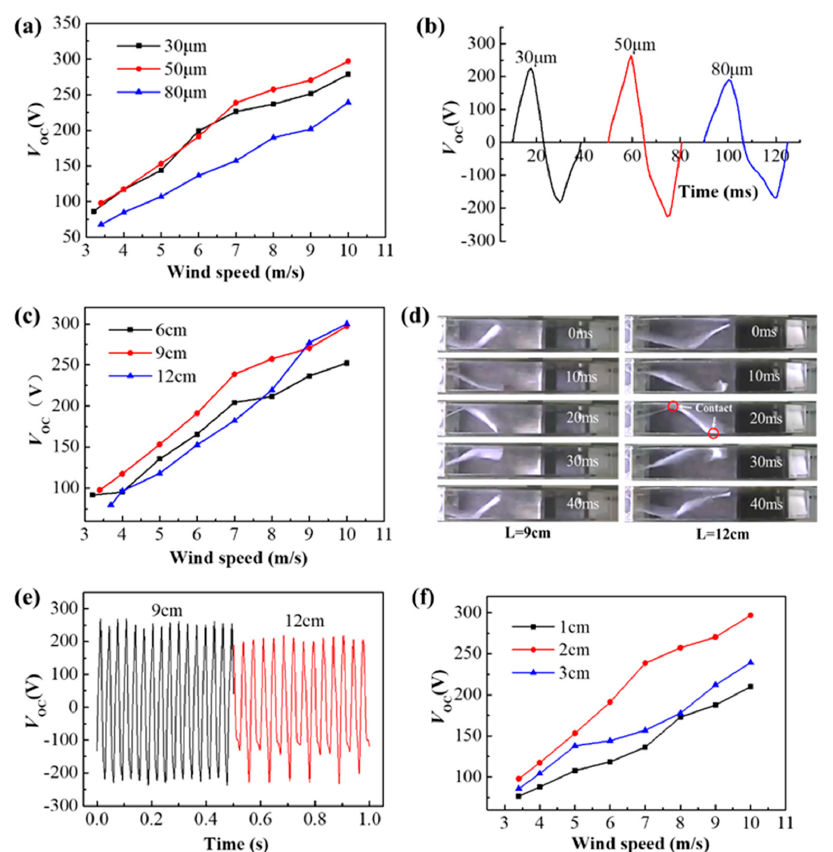
Figure 2. ( a ) Open-circuit voltage corresponding to three thicknesses of h = 30 μ m, 50 μ m, and 80 μ m at different wind speeds. ( b ) Single-cycle V OC waveform of three thickness films when the wind speed is 8 m/s. ( c ) Open-circuit voltage corresponding to three lengths of L = 6 cm, 9 cm, and 12 cm at different wind speeds. ( d ) Vibration photographs of a single-cycle for film lengths of L = 9 cm and L = 12 cm at a wind speed of 8 m/s. ( e ) the waveform diagram of V OC at L = 9 cm and L = 12 cm at a wind speed of 8 m/s for 0.5 s. ( f ) Open-circuit voltage corresponding to electrode plate distances of d = 1 cm, 2 cm, and 3 cm at different wind